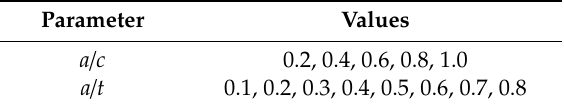
Table 1. Parameters assigned in finite element (FE) models.